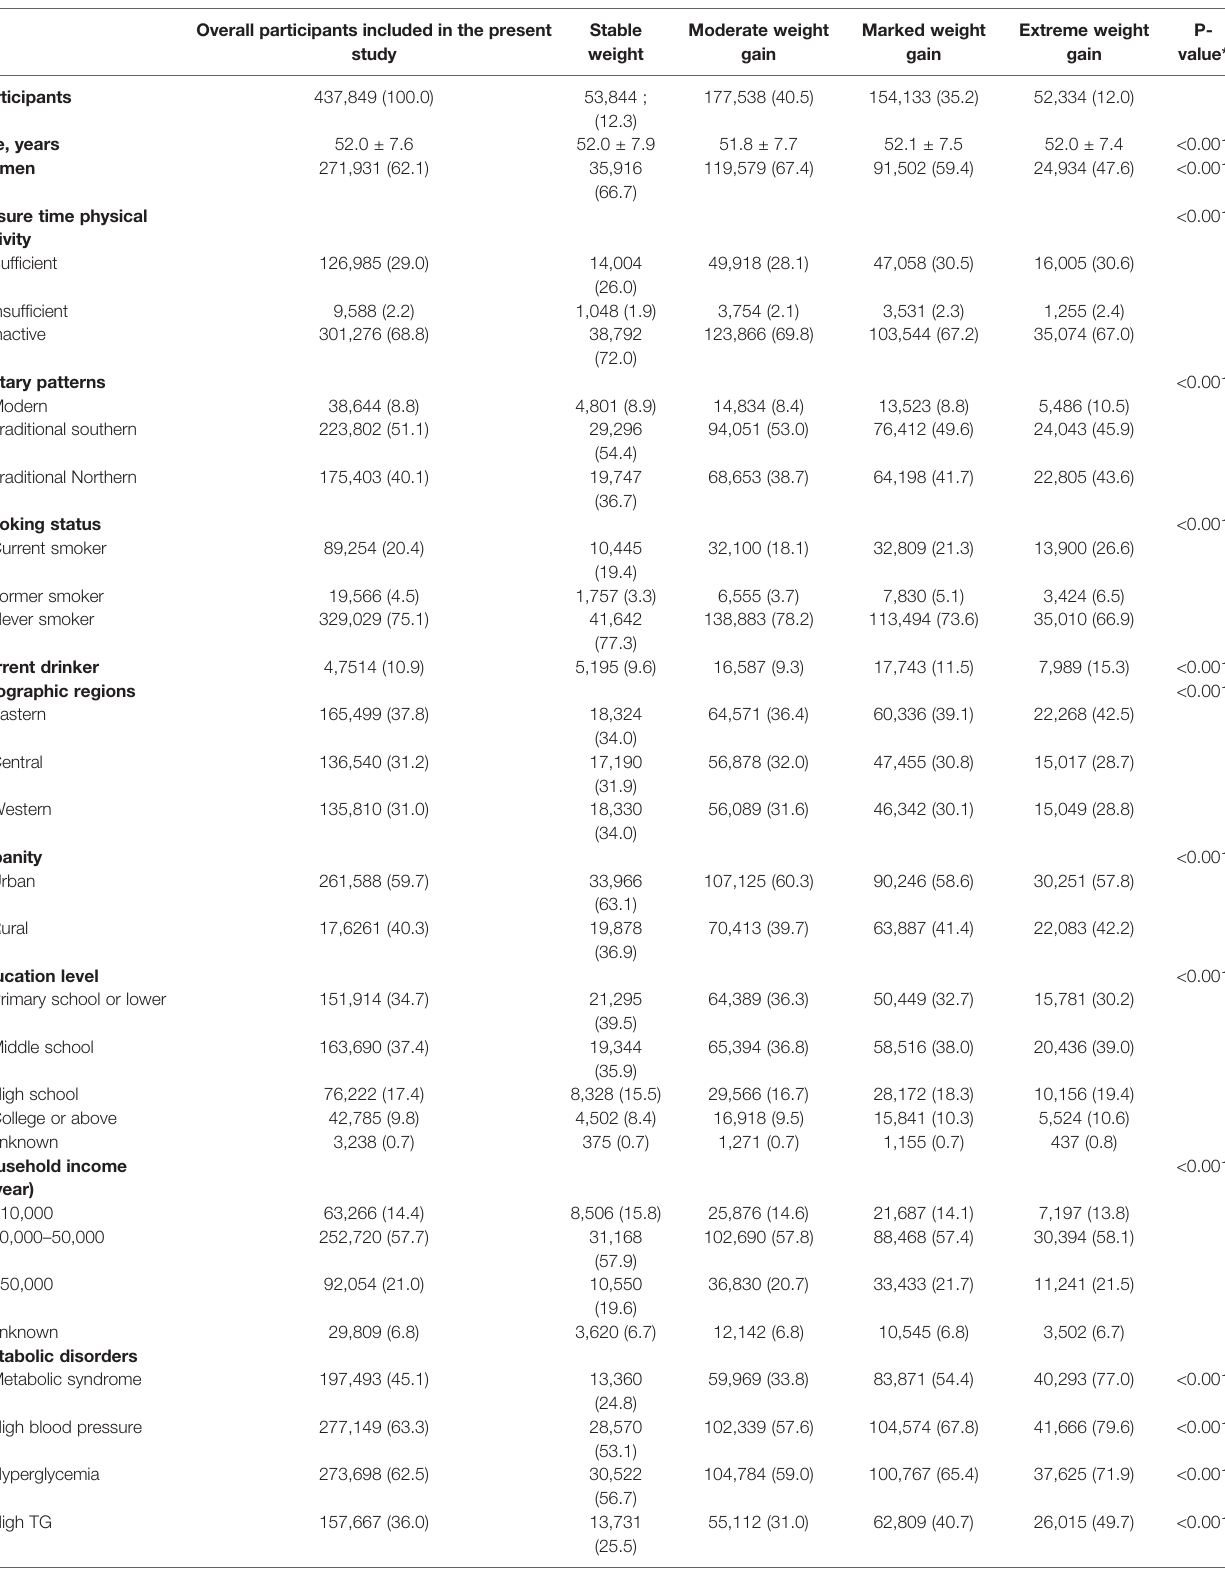
TABLE 1 | Participant characteristics at screening by weight gain categories.